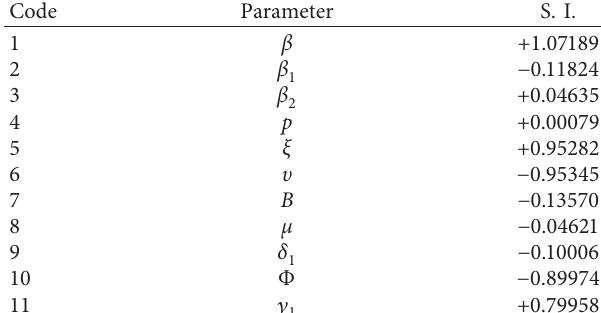
w.r.t the parameters. 0